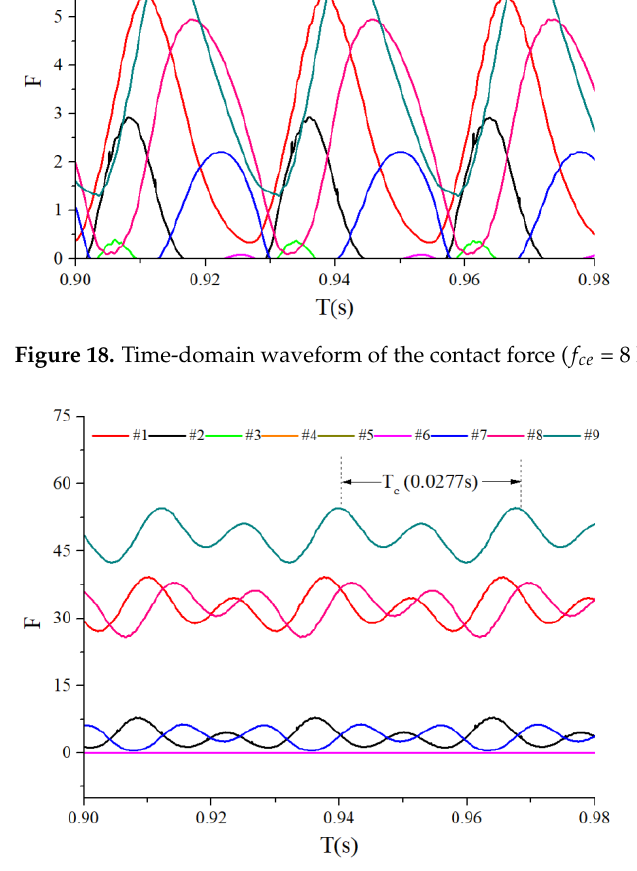
Figure 19. Time-domain waveform of the contact force ( f ce = 100 N).